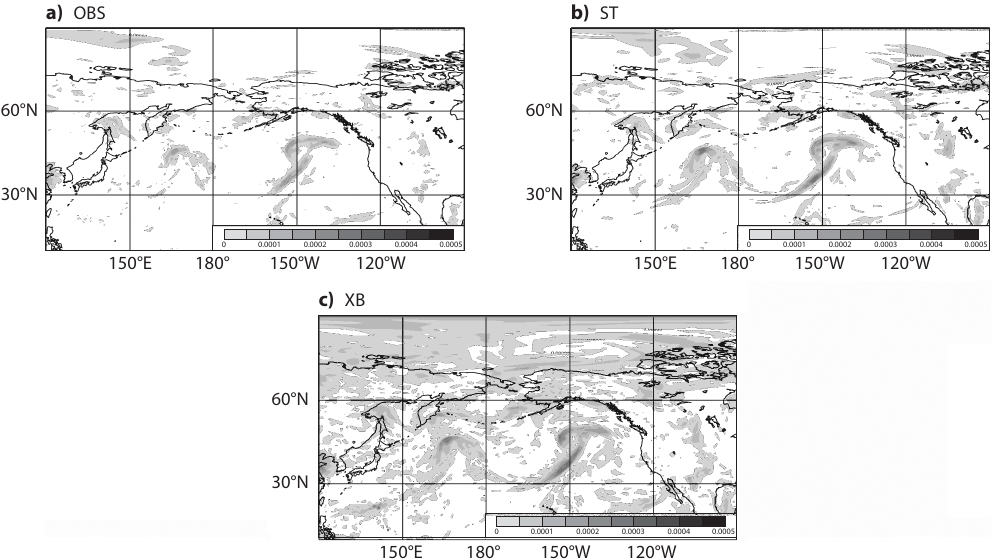
Figure 6. 6h forecast of vorticity field spread at 850hPa valid on 21 October 2008 at 12:00UTC. (a) OBS-EDA , (b) ST-EDA and (c) XB-EDA